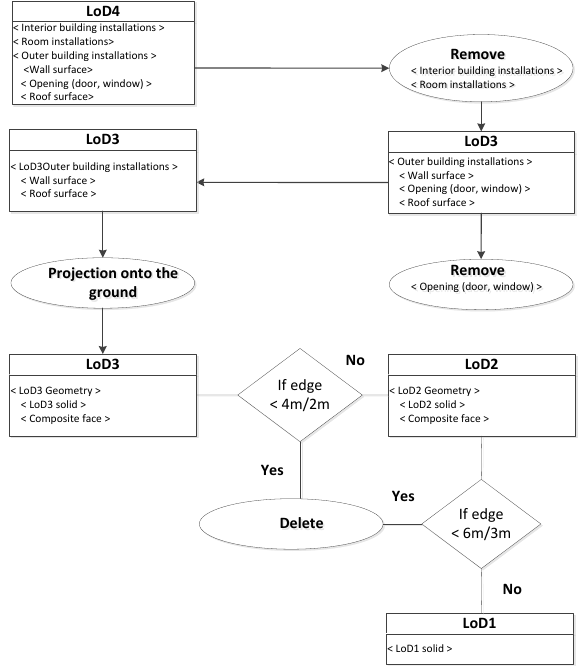
Table 1. CityGML’s generalization specifications adopted from (Gröger et al. , 2007)